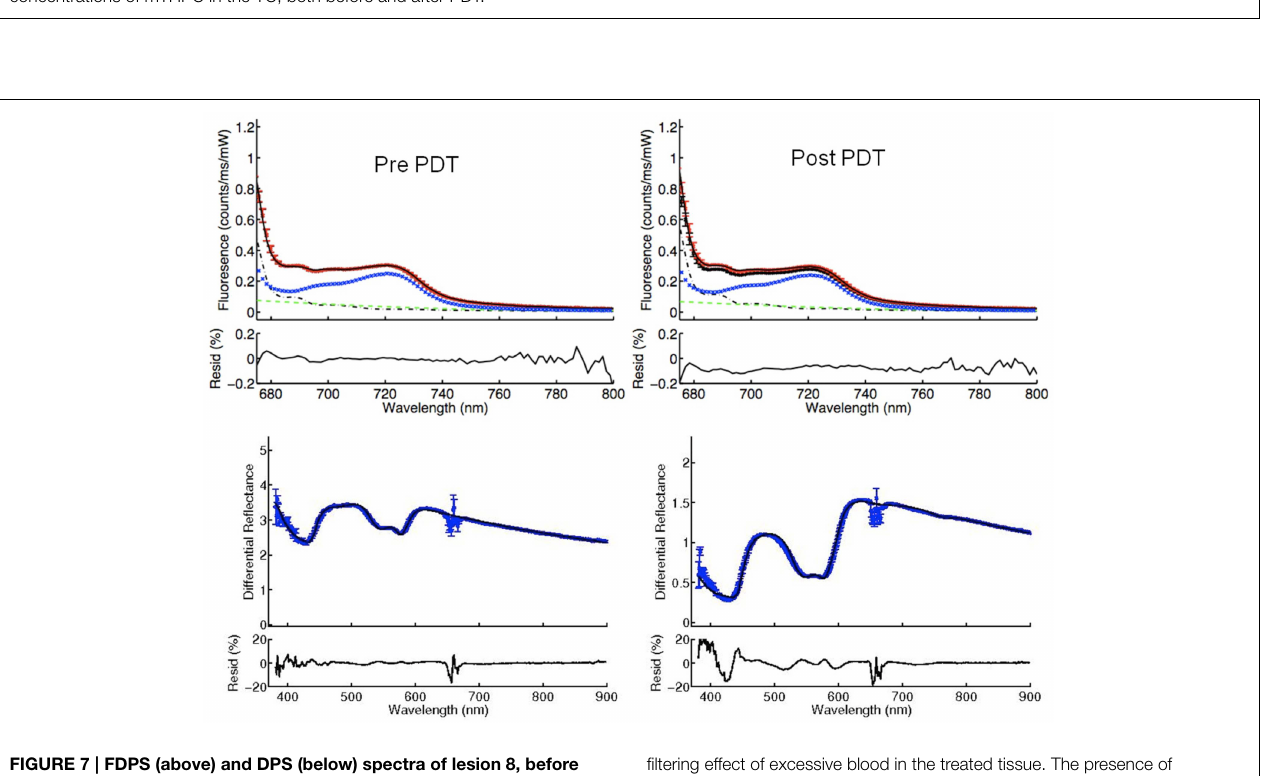
filtering effect of excessive blood in the treated tissue. The presence of excessive blood can be observed in the reflectance spectrum post PDT (below). The absorbance peaks of hemoglobin between 500 and 650nm post PDT are much deeper compared to pre PDT.